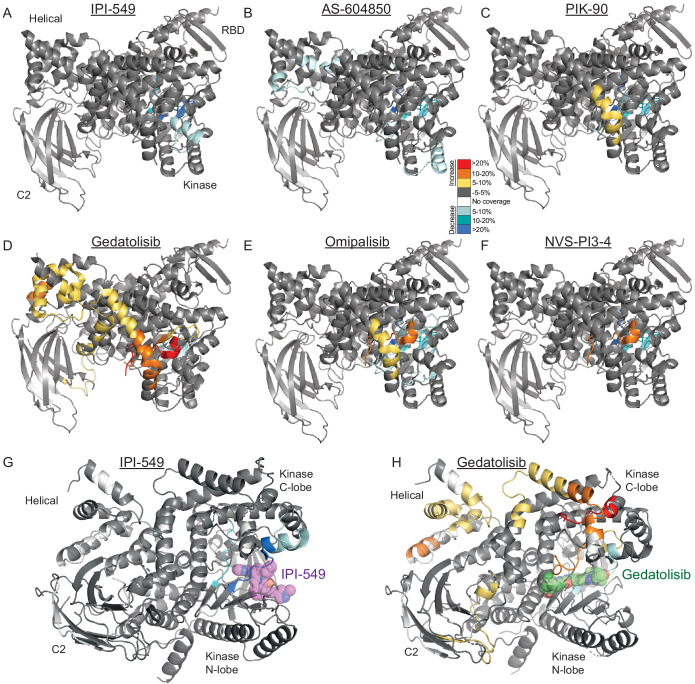
HDX-MS reveals that different classes of PI3K inhibitors lead to unique allosteric conformational changes.(A–F) Peptides showing significant deuterium exchange differences (>5%,>0.4 kDa and p<0.01 in an unpaired two-tailed t-test) between wild-type and six different inhibitors are coloured on a model of p110γ (PDB: 6AUD). Differences in exchange are mapped according to the legend. (G–H) The same HDX-MS differences in exchange mapped in panel A+D are shown on the crystal structure of p110γ bound to IPI-549 (G) and Gedatolisib (H). Both IPI-549 and Gedatolisib inhibitors are shown as spheres.